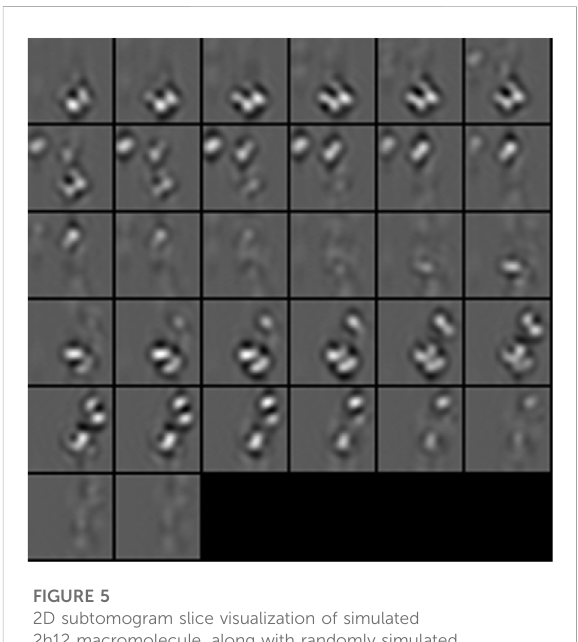
FIGURE 5 2D subtomogram slice visualization of simulated 2h12 macromolecule, along with randomly simulated macromolecules depicting a crowded subcellular environment.